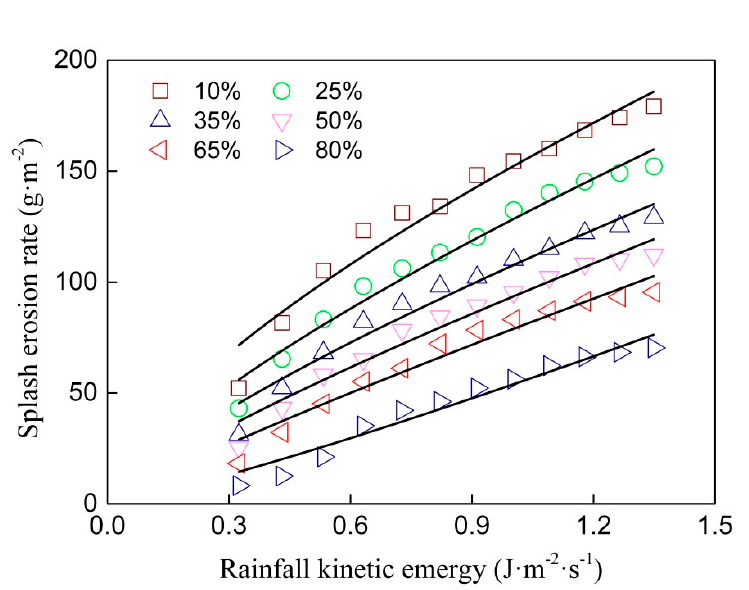
Figure 6. Relationship between splash erosion rate and rainfall kinetic energy under different herbaceous coverages.